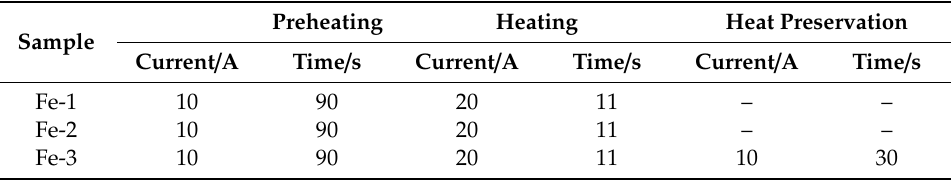
Figure 2. ( a ) Coating prepared mold and ( b ) schematic diagram of induction cladding device.